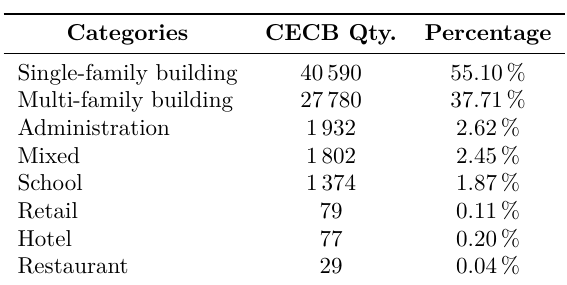
Table 1. Representation of the various building cate- gories in the CECB dataset.